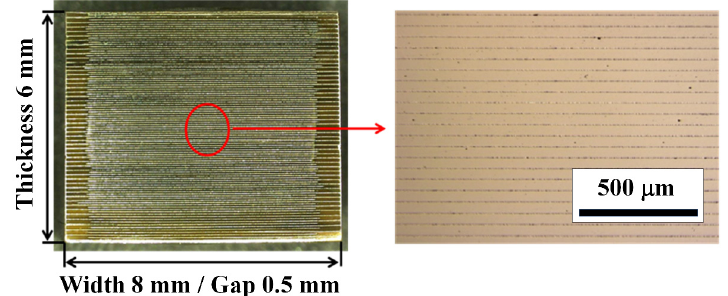
Figure 9. Optical microscope image of cross section of KNN ‐ CZ ‐ 3 multilayer actuator. The strain ‐ electric ‐ field curves are shown in Figure 10.